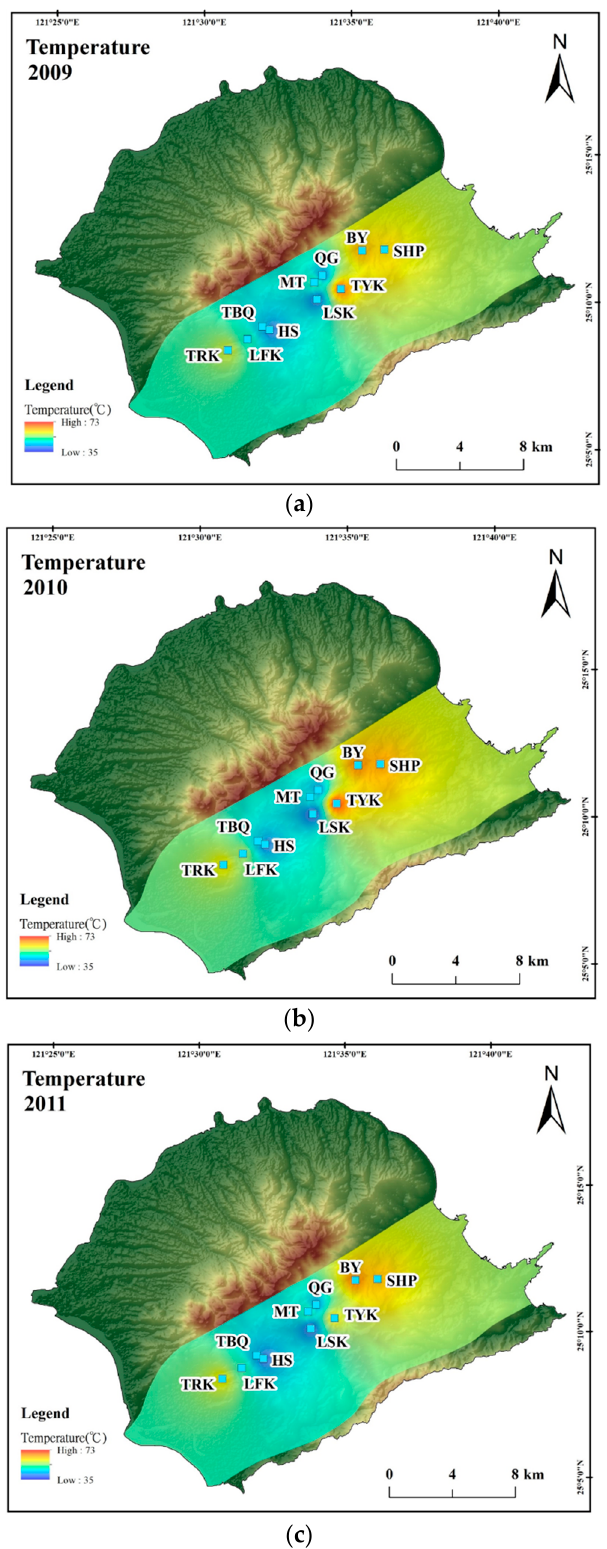
Figure 5. Temperature contour plots of the Tatun geothermal field hot spring for the three time periods ( a ) 2009; ( b ) 2010; ( c ) 2011.